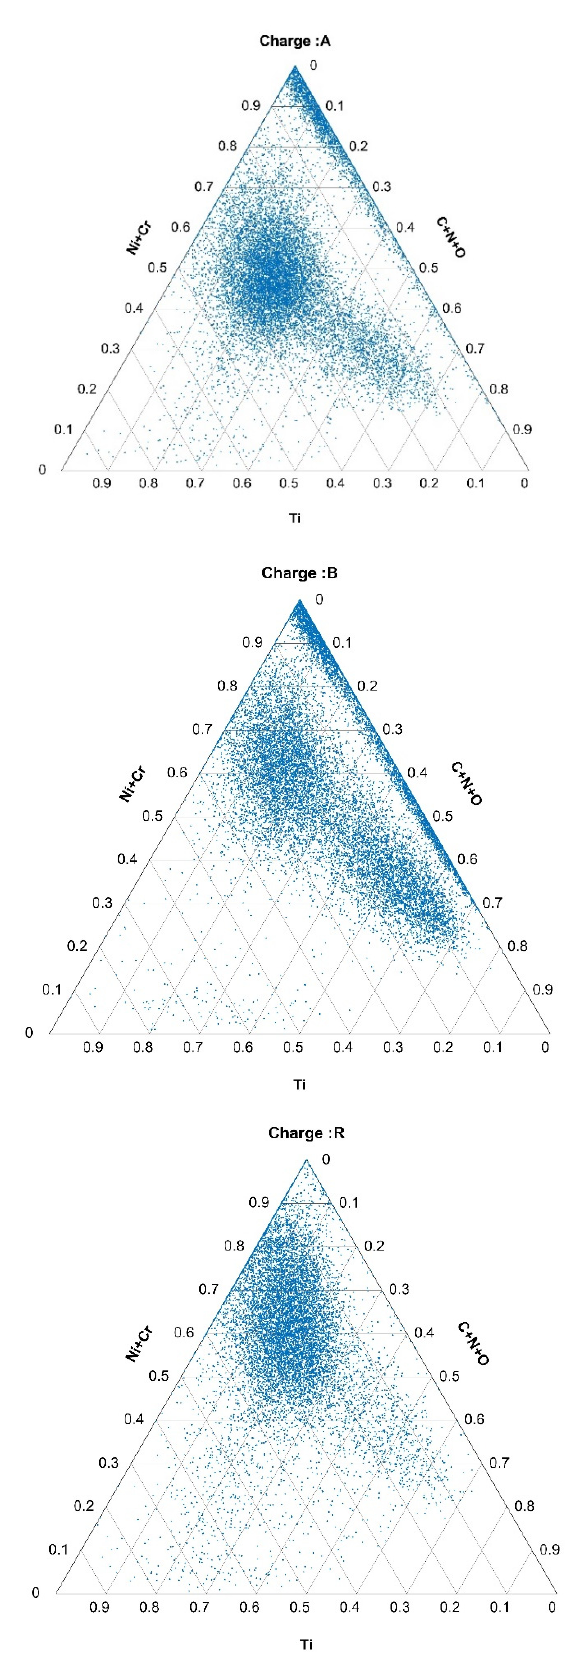
Figure 4. Composition of Ti-, C+N+O-, and Ni+Cr-rich inclusions in the hot-rolled plates of Ti- stabilized Cr-Ni-Mo steel A, B, and R.